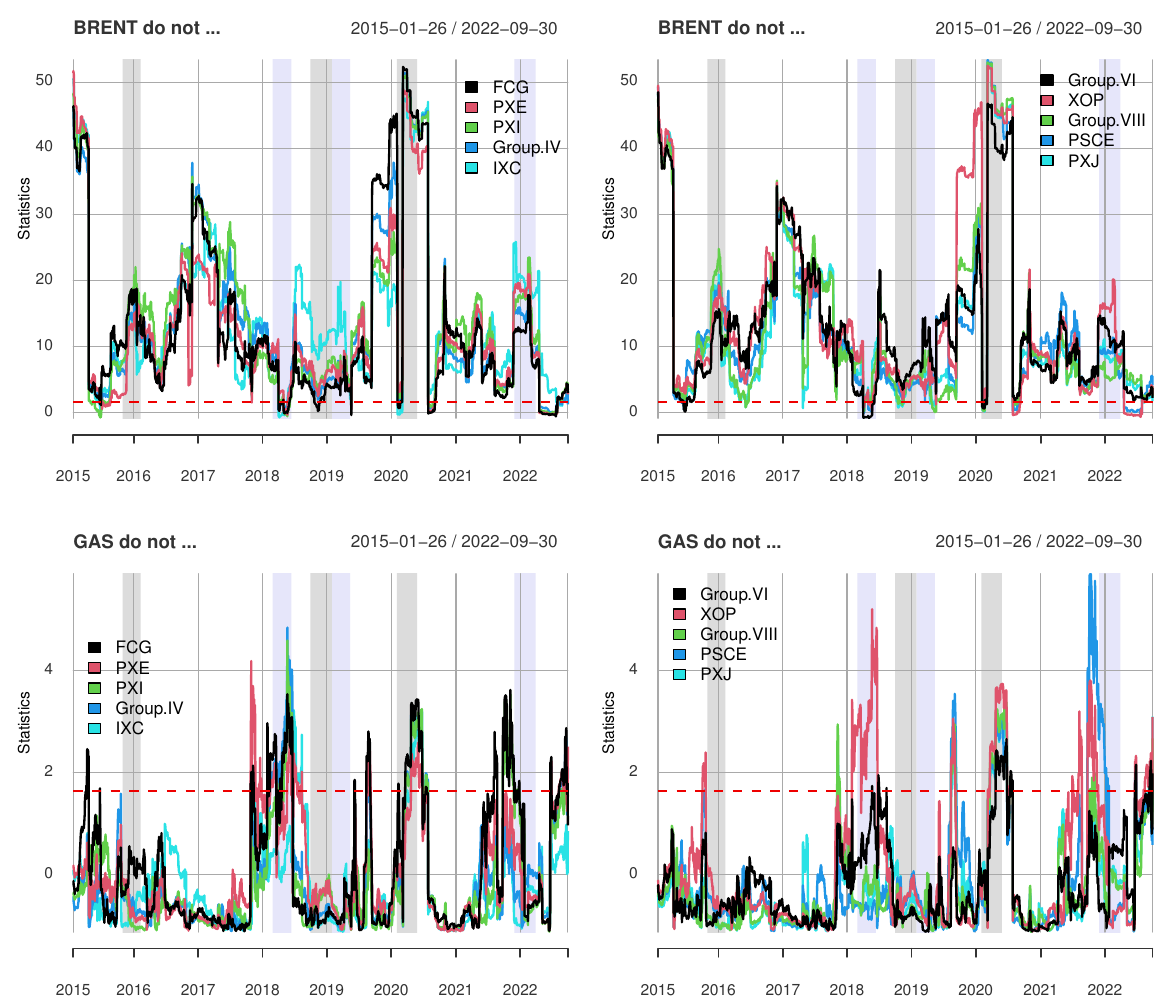
Figure 5. Rolling Hong tests between crude oil, natural gas and ETFs (causality-in-variance). Null hypothesis: BRENT/GAS do not instantaneous Granger-cause . . .. The red dashed line indicates the critical value of the H 3 test at the 5% significance